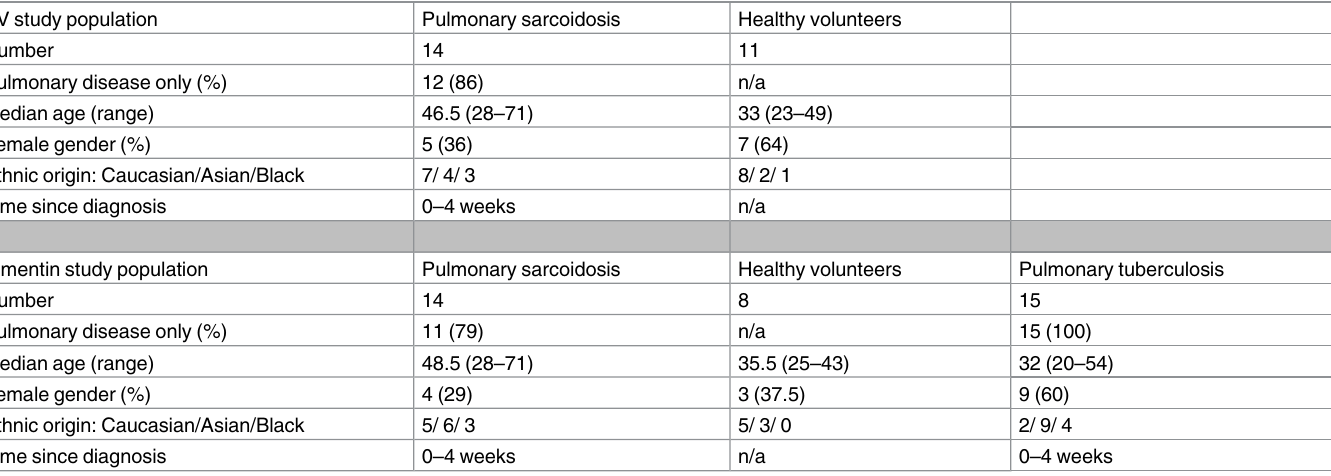
Demographic and clinical characteristics of patients with pulmonary sarcoidosis, pulmonary tuberculosis and healthy volunteers: 14 sarcoidosis